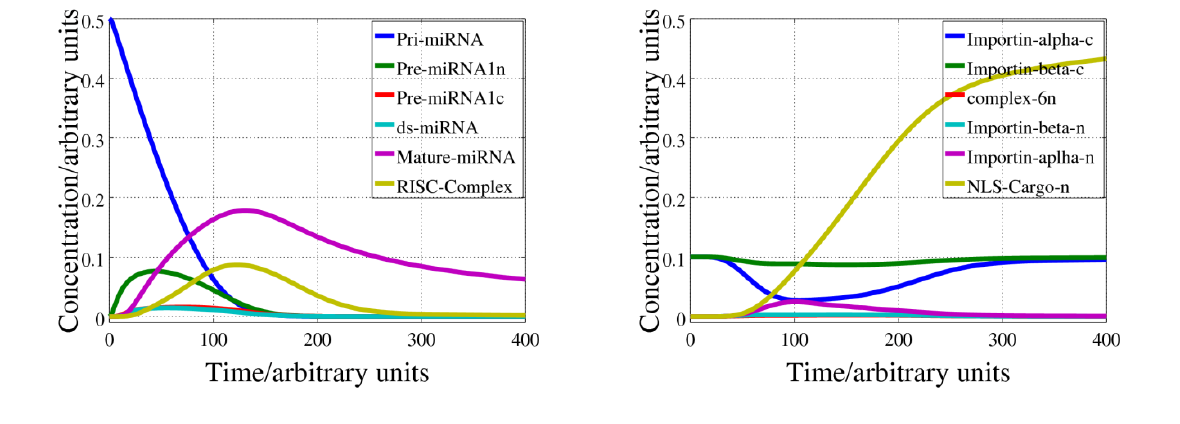
Figure 4: Classical Nuclear import simulations. In this simulation importin initial concentrations are non-zero and the result is almost quantitative transport of NLS-Cargo-n.